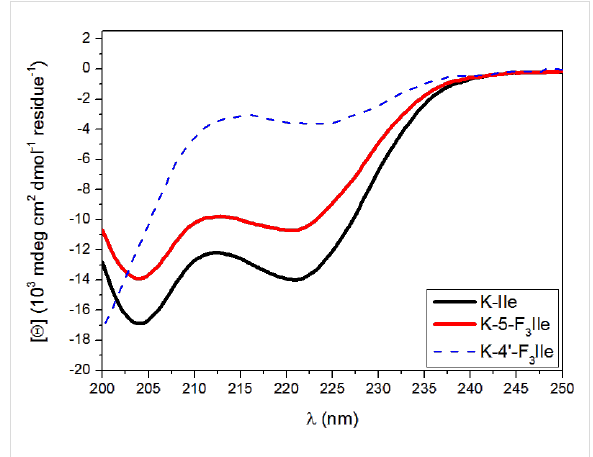
Figure 2: CD spectra of K-5-F 3 Ile and K-Ile peptides (KX: Ac-YGGKAAAAKA X AAKAAAAK-NH 2 ). The K-4’-F 3 Ile spectrum [13] is shown for comparison. Spectra were recorded at pH 7 in 1 mM phos- phate, borate, and citrate buffer with 1 M NaCl at 0 °C. Depicted spectra are normalized and represent the mean of three independent measurements at three different concentrations (80 µM, 50 µM, and 30